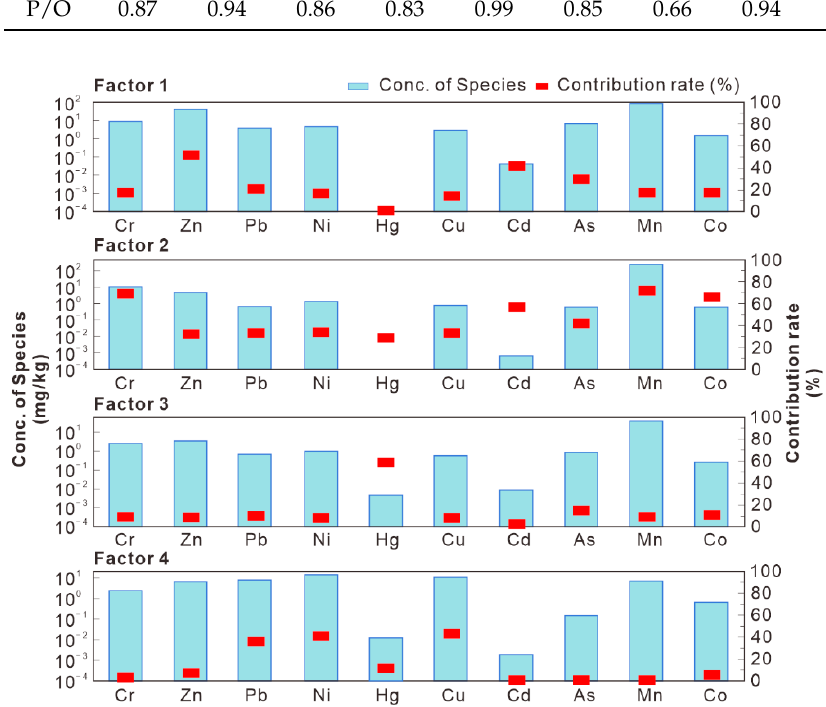
Figure 5. Concentration and contribution rate of HMs from various PMF-source factors.